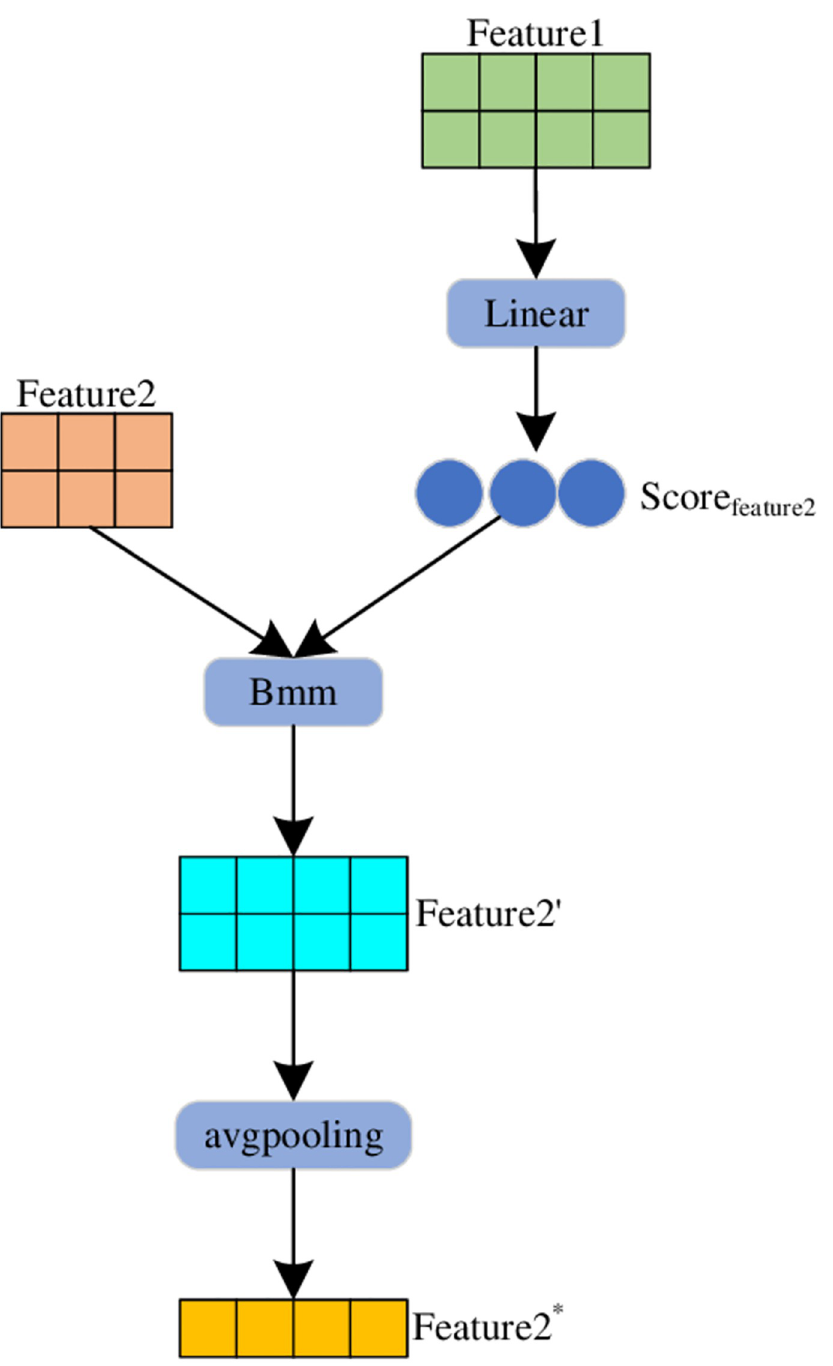
Fig 3. Multimodal fusion of SE modules